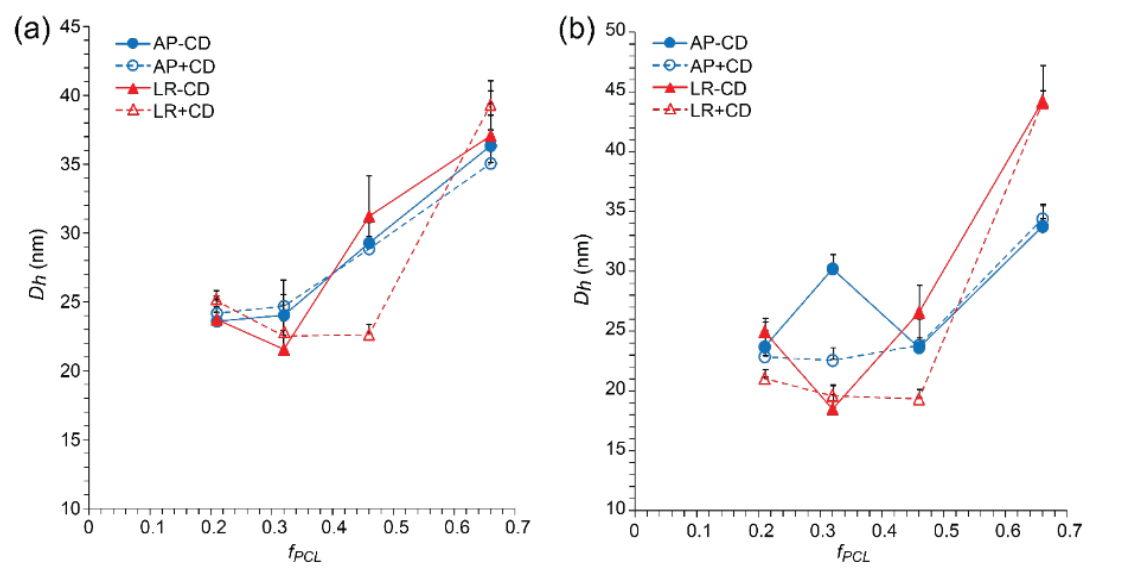
Figure 4. D h versus f PCL as determined from number PSDs for ( a ) gossypol (GP) and ( b ) phloretin (PH)-loaded PEG 5 PCL 1.3 , PEG 5 PCL 2.4, PEG 5 PCL 4.2 , and PEG 5 PCL 9.5 micelles as prepared (AP), after lyophilization/reconstitution (LR), and in the absence and presence of β-CD (−/+CD). All values are reported as the mean + std. dev. ( n = 3).